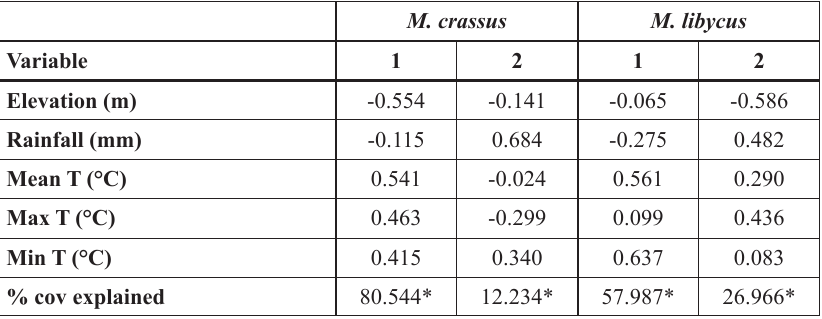
Table 4. The 2B-PLS results derived from species-specific analyses in Meriones crassus Sundevall, 1842 and M. libycus Lichtenstein, 1823. The relationship between each of the first two vectors and the geoclimatic variables are represented by the correlation coefficient and the percentage of covariation (*p <